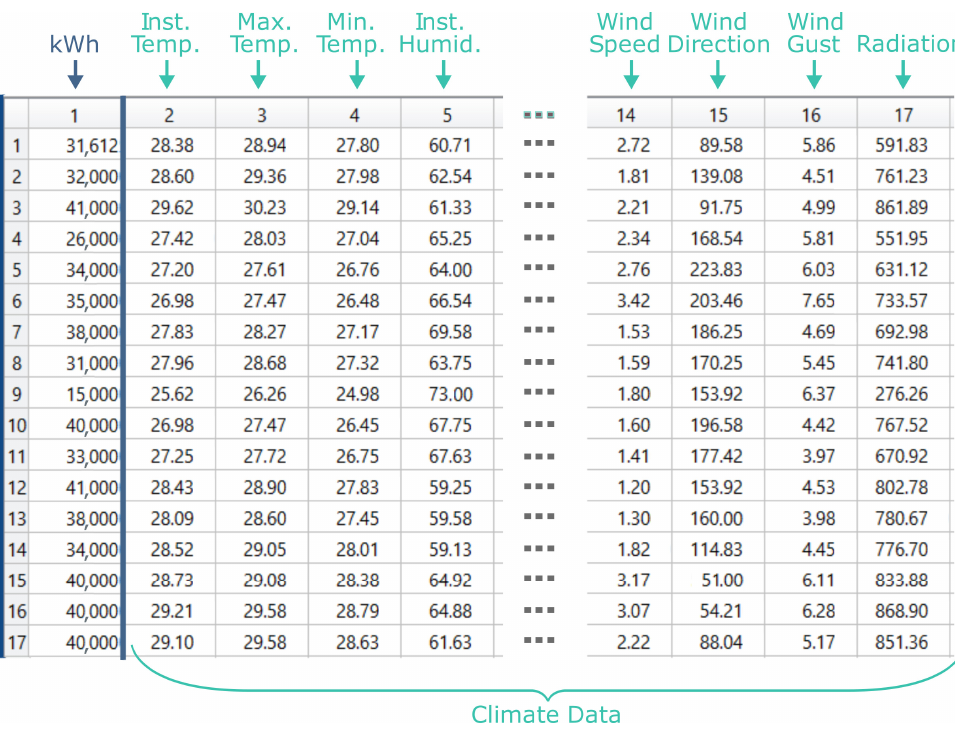
Figure 4. PCA is applied to reduce the climatic variables of columns 2 to 17. Source: own authors.